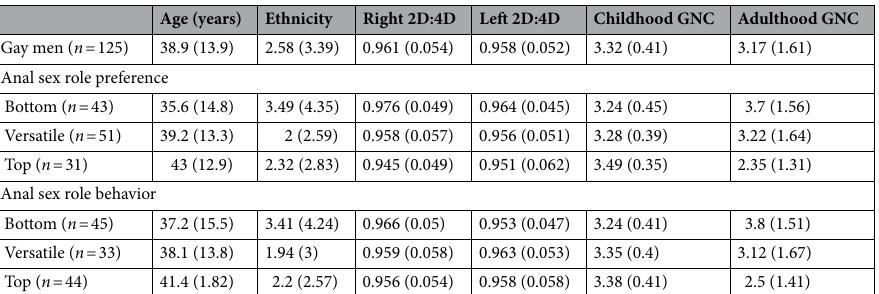
Table 1. Descriptive statistics by ASR preference and behavior groups: mean (SD). Ethnicity was measured on a 13-point scale (1 = Caucasian, 2 = Black, 3 = Chinese, 4 = Filipino, 5 = Aboriginal, 6 = Latin American, 7 = Arab, 8 = Southeast Asian, 9 = West Asian, 10 = Korean, 11 = Japanese and 12 = other). Right- and left-hand digit ratios were calculated by dividing the length (mm) of the index finger (2D) by the length of the ring finger (4D). Childhood GNC was calculated based on an 18-item questionnaire, where lower scores indicate more gender nonconformity 10 . Adulthood GNC scores are derived from a on a 7-point Likert scale: 0 (more masculine), 3 (same), 6 (more feminine), thus higher scores indicate more gender nonconformity.